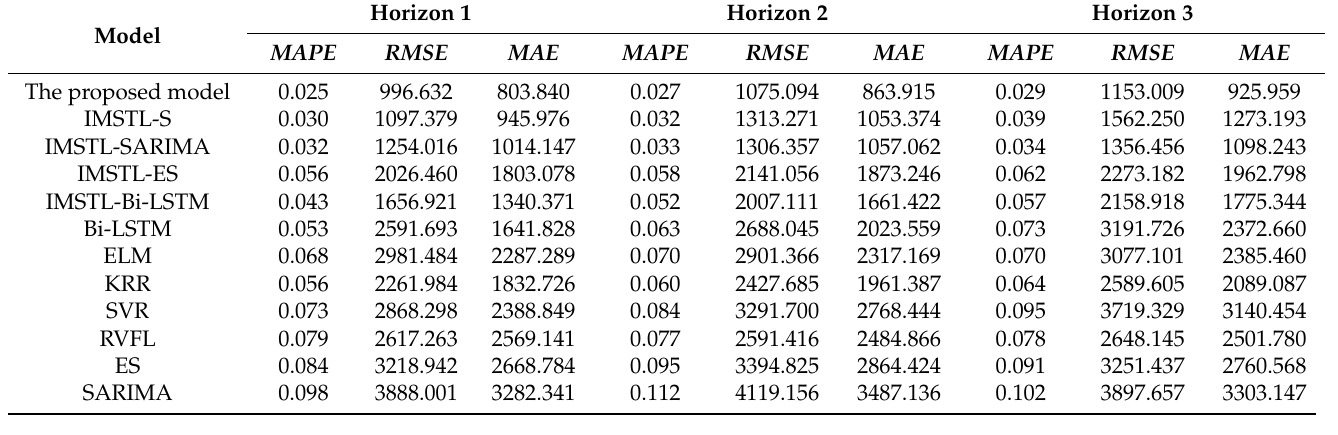
Table 6. Prediction performance of different models.